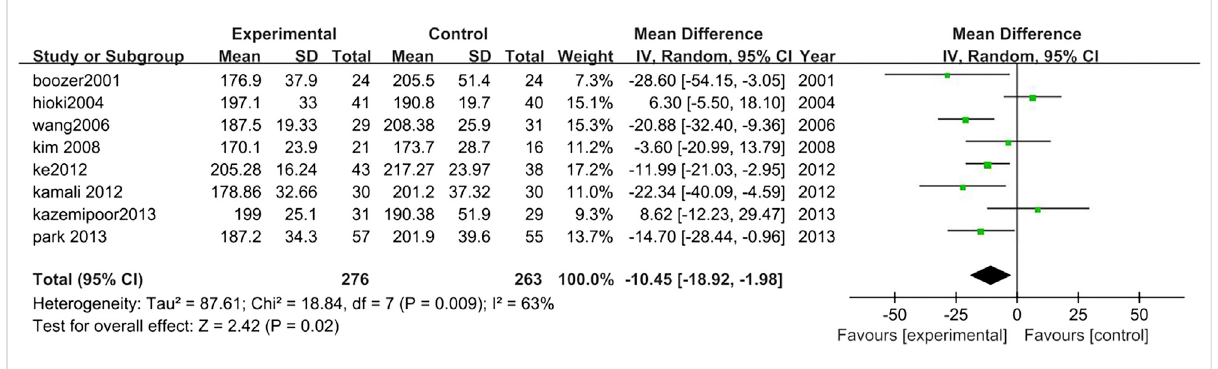
FIGURE 9 Forest plot of TCHO. Comparison: TCM treatment vs. placeo or blank control.